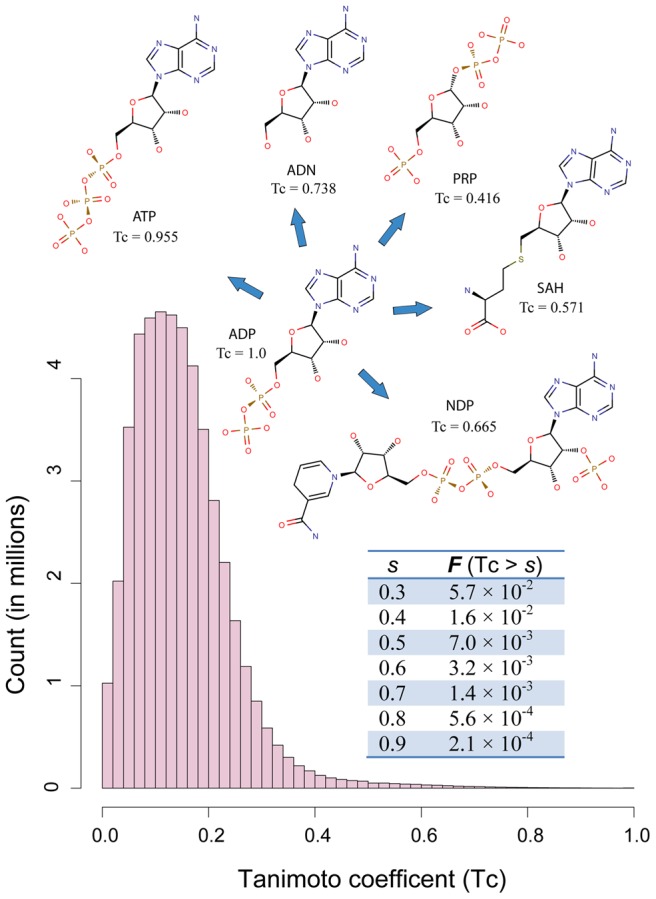
Distribution of Tanimoto coefficient scores of small-molecule compounds found in the PDB.Tc scores from all-against-all comparison of 9,485 ligands were employed to create the histogram. Insert table shows the fraction of Tc scores higher than threshold scores. Insert diagrams display chemical structures of ADP and five structurally related ligands: adenosine triphosphate (ATP), adenosine (ADN), NADPH dihydro-nicotinamide-adenine-dinucleotide phosphate (NDP), S-adenosyl-L-homocysteine (SAH), and α-phosphoribosylpyrophosphoric acid (PRP). Their Tc scores in comparison to ADP are provided under their name labels.